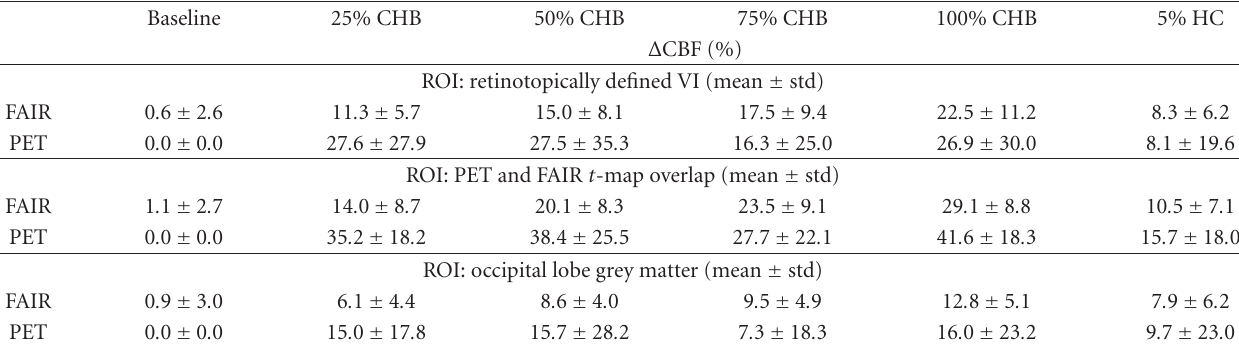
Table 2: FAIR and PET CBF percent changes averaged over all subjects (mean ± std), for all conditions (baseline, 4 levels of visual checkboard (CHB) stimulation, and hypercapnia (HC)), in the V1, t -map, and GM ROIs. For PET, the baseline percent change was fixed at 0%, since only one baseline volume was